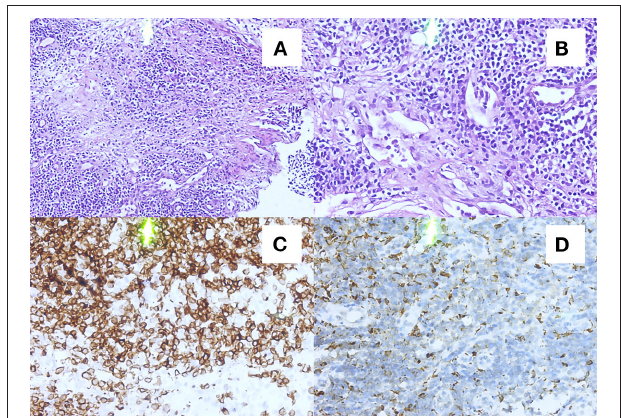
FIGURE 2 | Histopathological and immunohistochemical findings of cervical lymph nodes. Hematoxylin–eosin staining showing hyperplasia, histiocytosis, and a few nuclear fragments in the left cervical lymph node sections. (A,B) Immunohistochemical staining showing CD3 + (C) and CD68 + (D) expression in the left side cervical lymph node